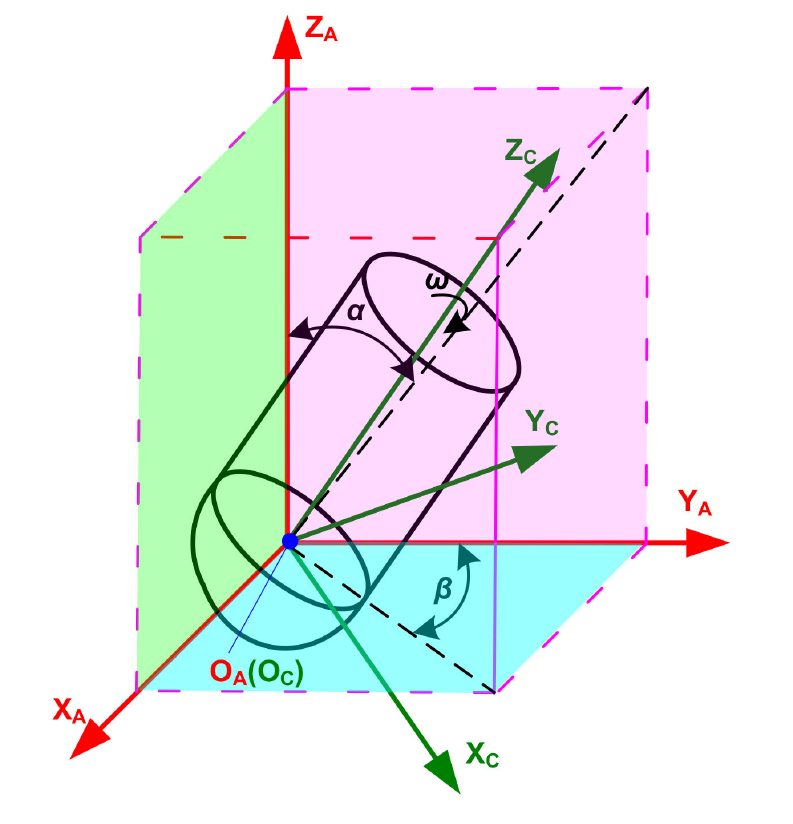
Figure 2. Adjustment of the cutter’s